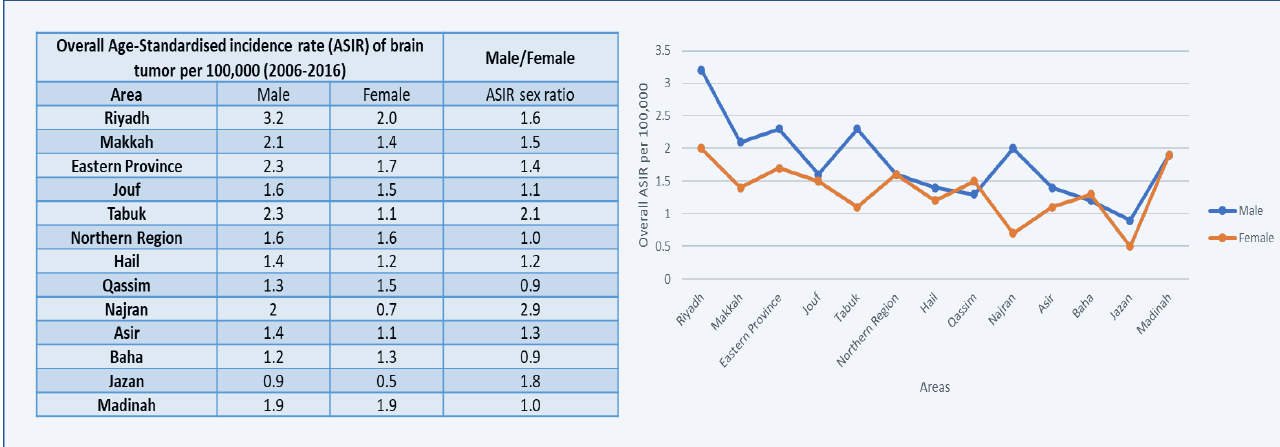
Figure 6. Overall ASIRs of brain tumor cases per 100,000 between males and females according to administrative areas from 2006 to 2016.